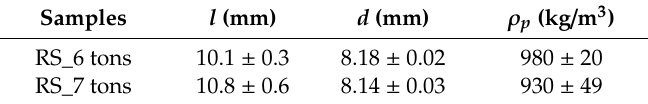
Table 2. Averaged results of physical properties of RS pellets produced at lab conditions.